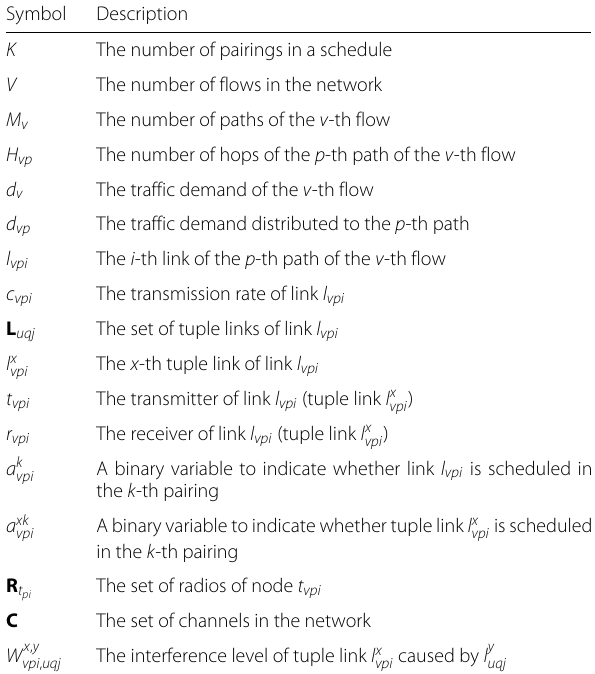
demand and the traffic demand distributed to the p -th path as d v and d vp , respectively. The links of a path are sorted by the links’ hop number, i.e., the link of the first hop of the p -th path is denoted as the first link of the p - th path. The i -th link of the p -th path of the v -th flow is defined as l vpi , and its transmission rate is c vpi . According